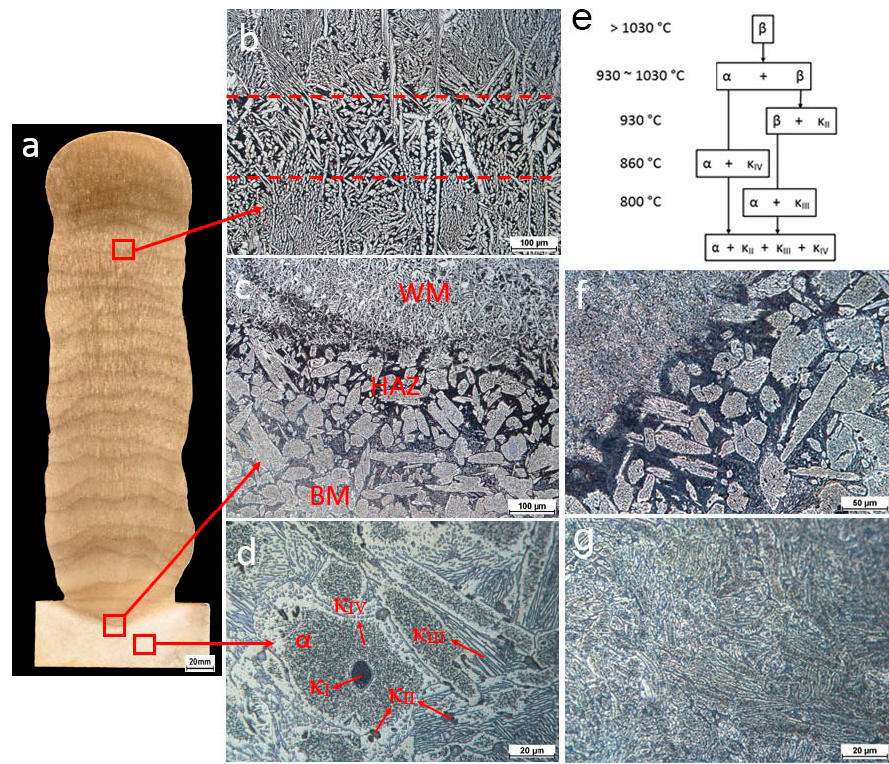
Figure 5. Microstructure of the deposited NAB components: ( a ) macro photography of the cross-section of the wall structure; ( b ) representative microstructure in the weld metal; ( c ) morphology of the HAZ; ( d ) representative microstructure in the base metal; ( e ) formation of transformed products in NAB alloys; ( f ) typical microstructure of the HAZ after PWHT; and ( g ) typical microstructure of the weld metal after PWHT.